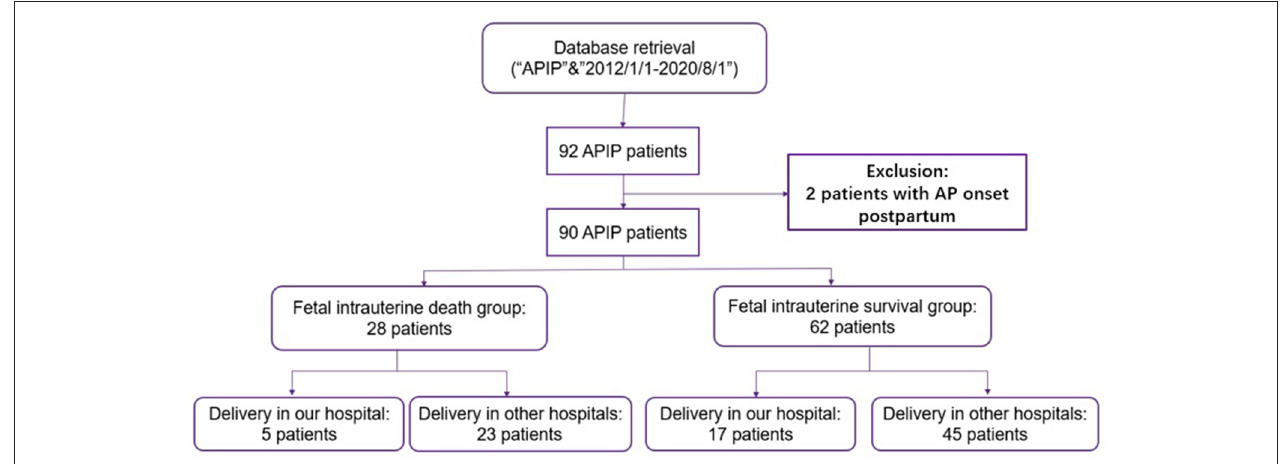
FIGURE 1 | The flowchart of the inclusion and exclusion criteria. APIP, acute pancreatitis in